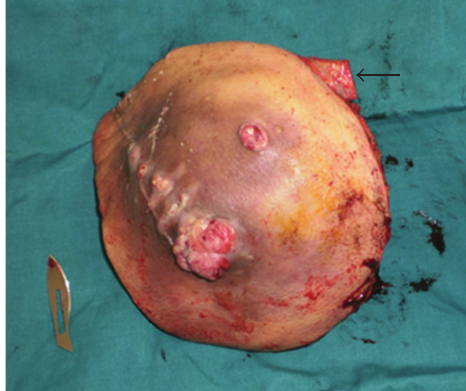
Figure 1: An infected recurrence on the lobotomy scar.